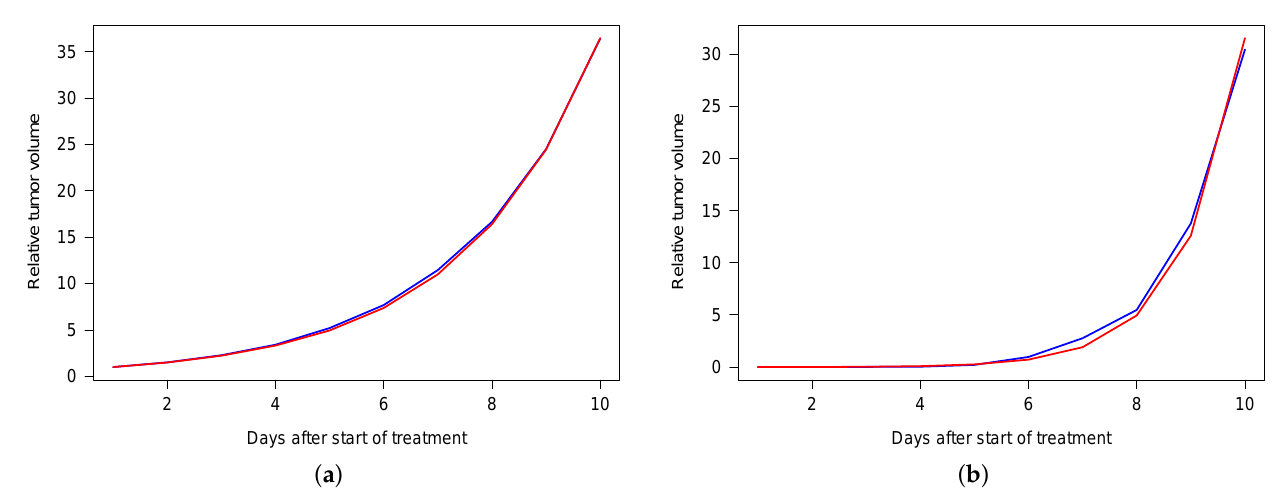
Figure 3. Mean ( a ) and variance ( b ) of simulated sample paths (in blue) and the fitted model (in red) for σ = 0.05.